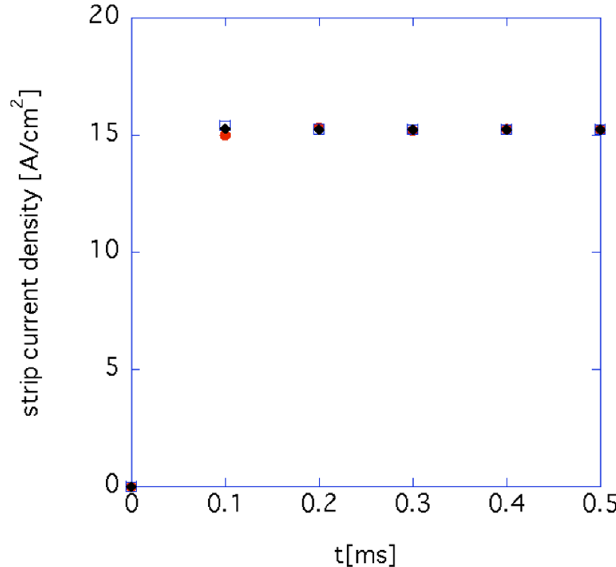
FIG. 21. (Color) The dependence on the mesh size of the current density for Cu stripes specified with ID ¼ 11 . The red, blue, and black points represent the results where the mesh size is 0.1, 0.05, and 0.025 ms,